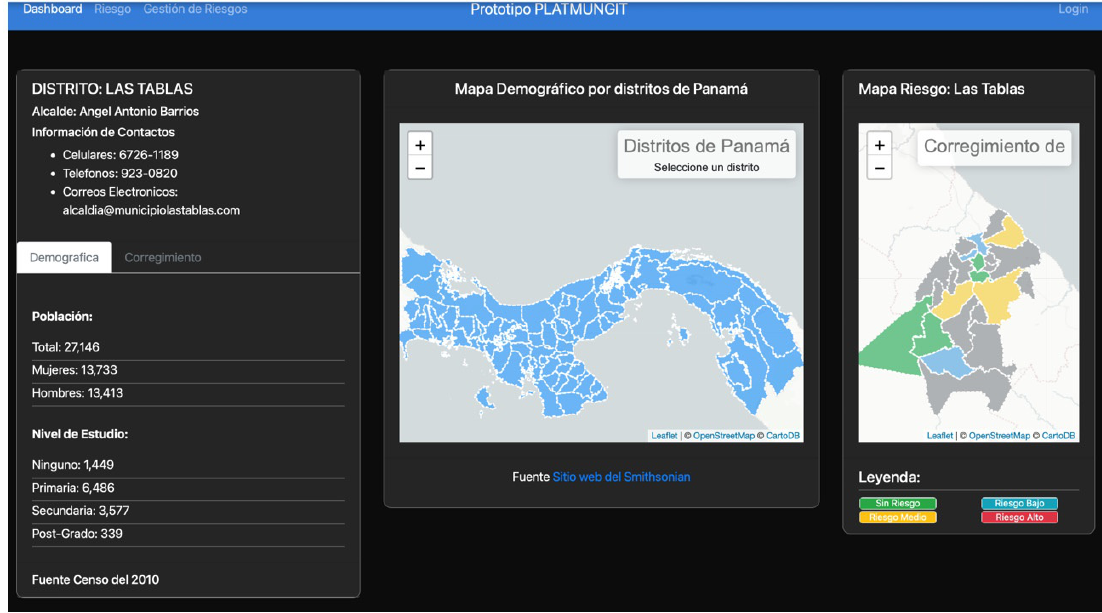
Figure 8. Risk monitoring dashboard prototype.